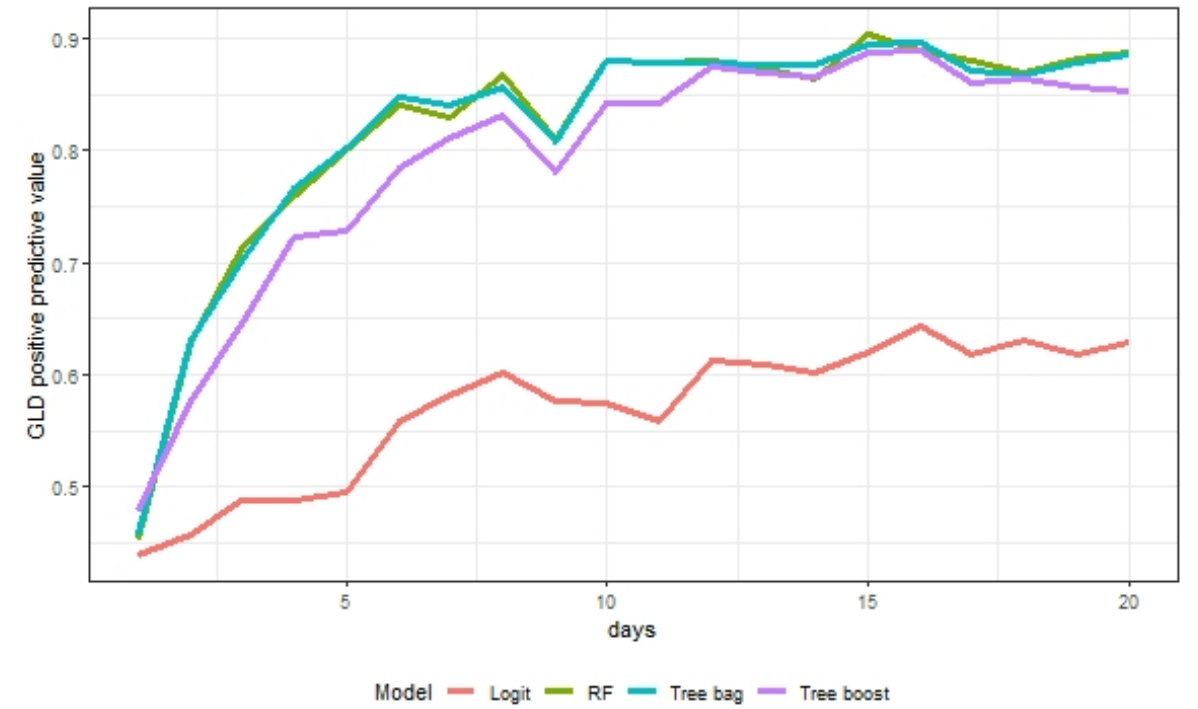
J. Risk Financial Manag. 2021 , 14 , x FOR PEER REVIEW